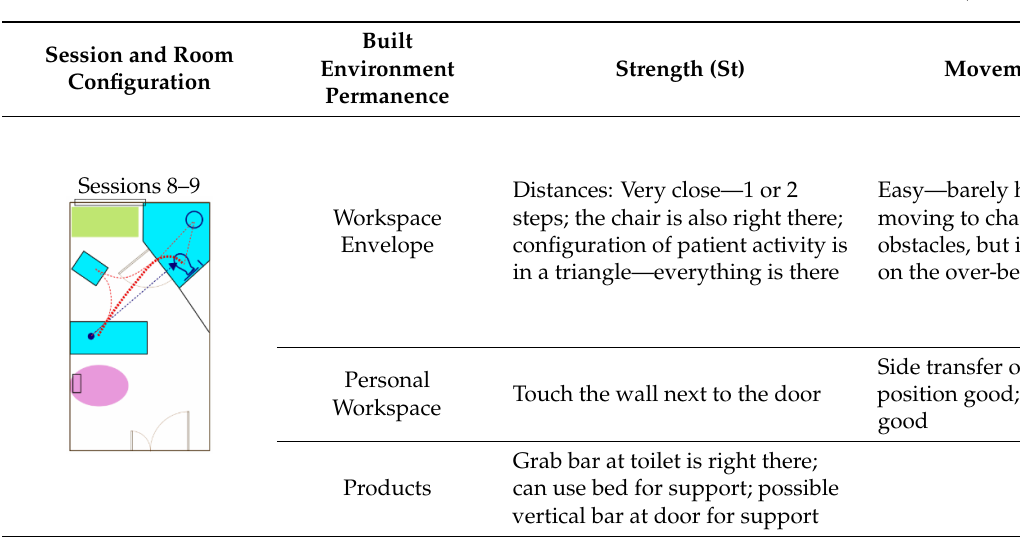
Table 5. Session 8–9 Feedback (Room 4—Outboard